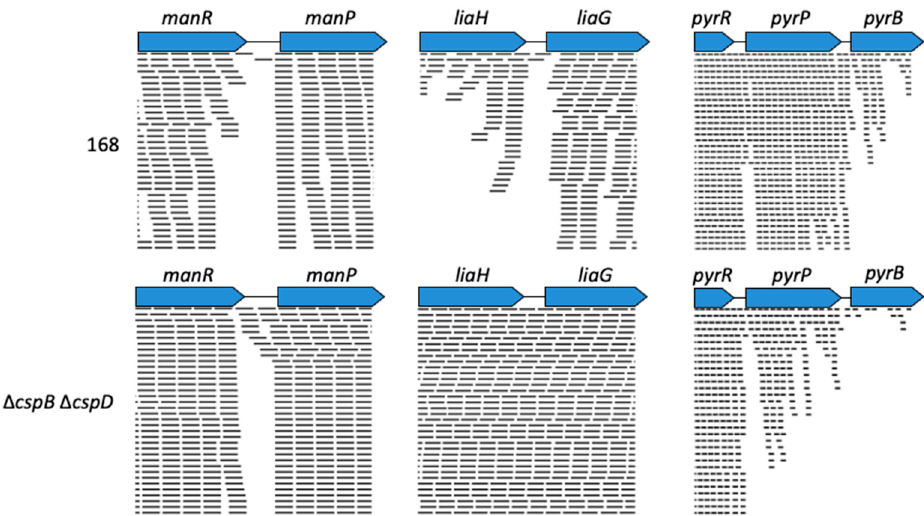
Figure 6. Differences in transcription in 168 and the ∆ cspB ∆ cspD mutant. The intergenic regions between manR-manP , liaH-liaG , pyrR-pyrP-pyrB in B. subtilis wild type 168 (upper panel) and the ∆ cspB ∆ cspD mutant GP1971 (lower panel) aligned with the paired reads generated by RNA-sequencing are shown. The data are representative of three biological replicates. Pictures of aligned reads were created using the Geneious Software version 2020.0.4 (Biomatters Ltd., New Zealand).